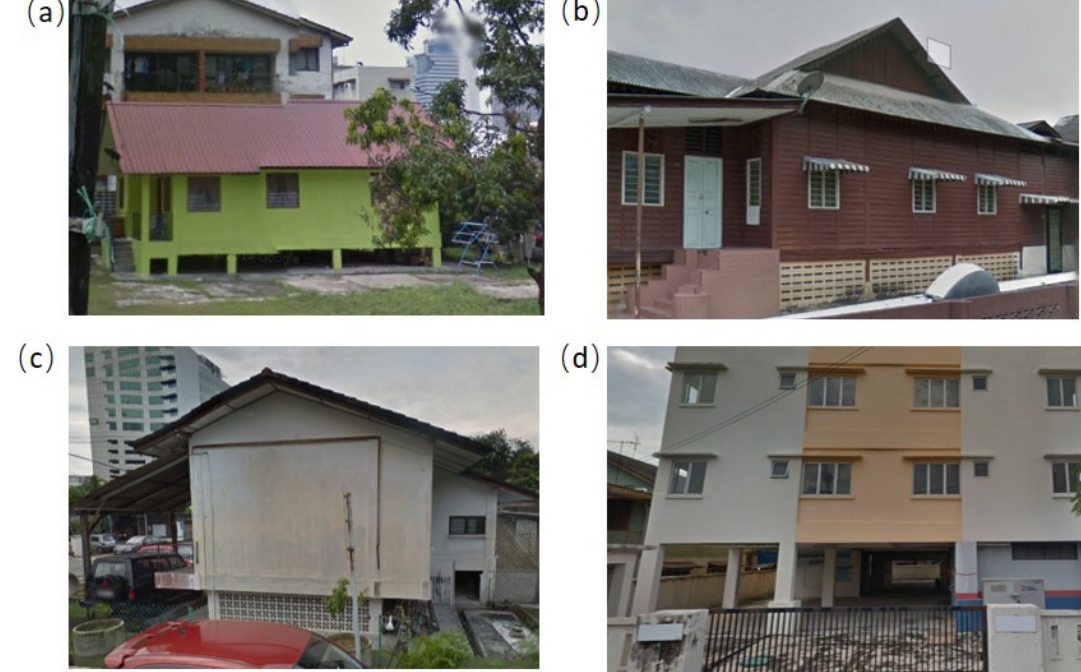
Figure 3. Typical buildings with stilts: ( a , b ) are more traditional buildings while ( c , d ) are modernized. Table 1. Parameters of four SMART operational